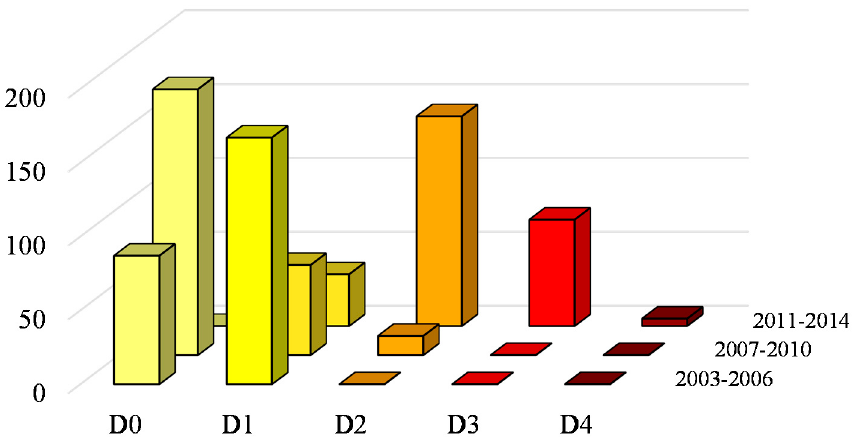
Figure 7. Categorization of averaged drought severity in Oklahoma in 2003–2014. Source: Authors’ calculations and visualization.